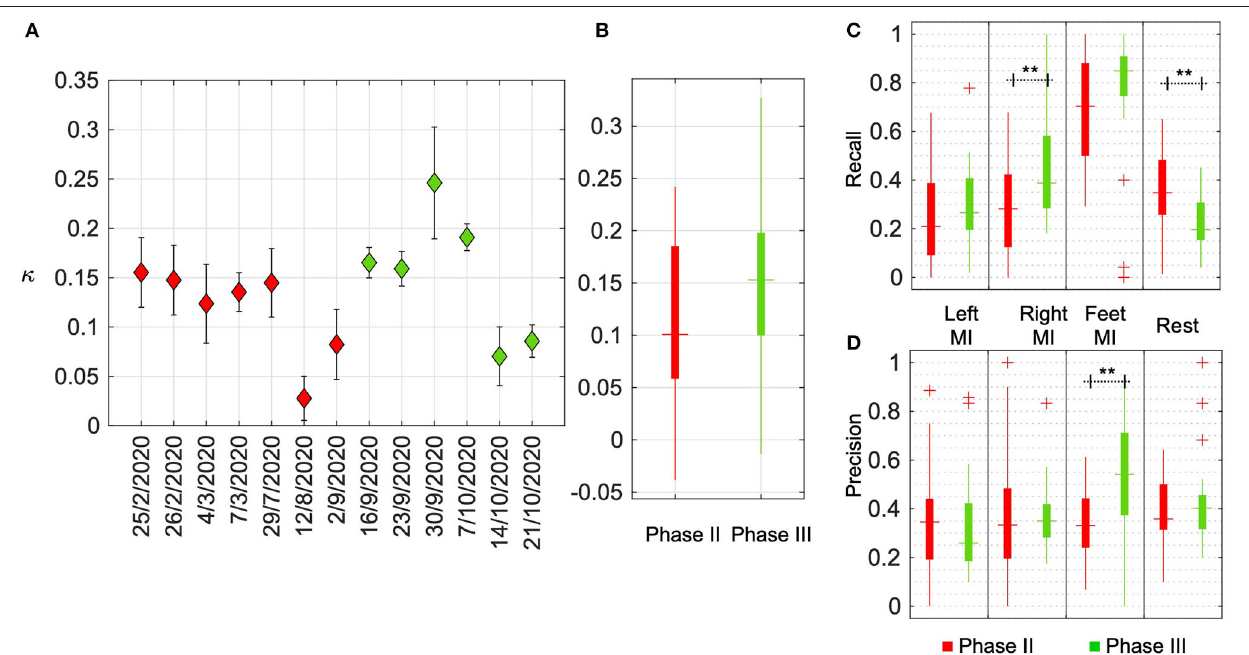
FIGURE 5 | Evaluation of BCI performance using κ . (A) The figure shows κ for each session in phase II (in red) and phase III (in green). In each session, the pilot played four games and the data points indicate the mean and its standard error of κ . (B) The overall performance across all the sessions is displayed in red and green boxes indicating the performances in phase II and phase III, respectively. In each box, the horizontal dash indicates median value, the top and bottom edge of the box indicates the 25th and 75th percentiles, while the vertical line indicates the range of values. (C,D) The recall and precision values, respectively, across sessions for each of the MI classes. The columns indicate the metrics for each class, ω ∈ {Left MI, Right MI, Feet MI, Rest} and the boxplots show the change in these metrics from phase II to phase III. Columns marked with ** imply statistically significant differences with p <